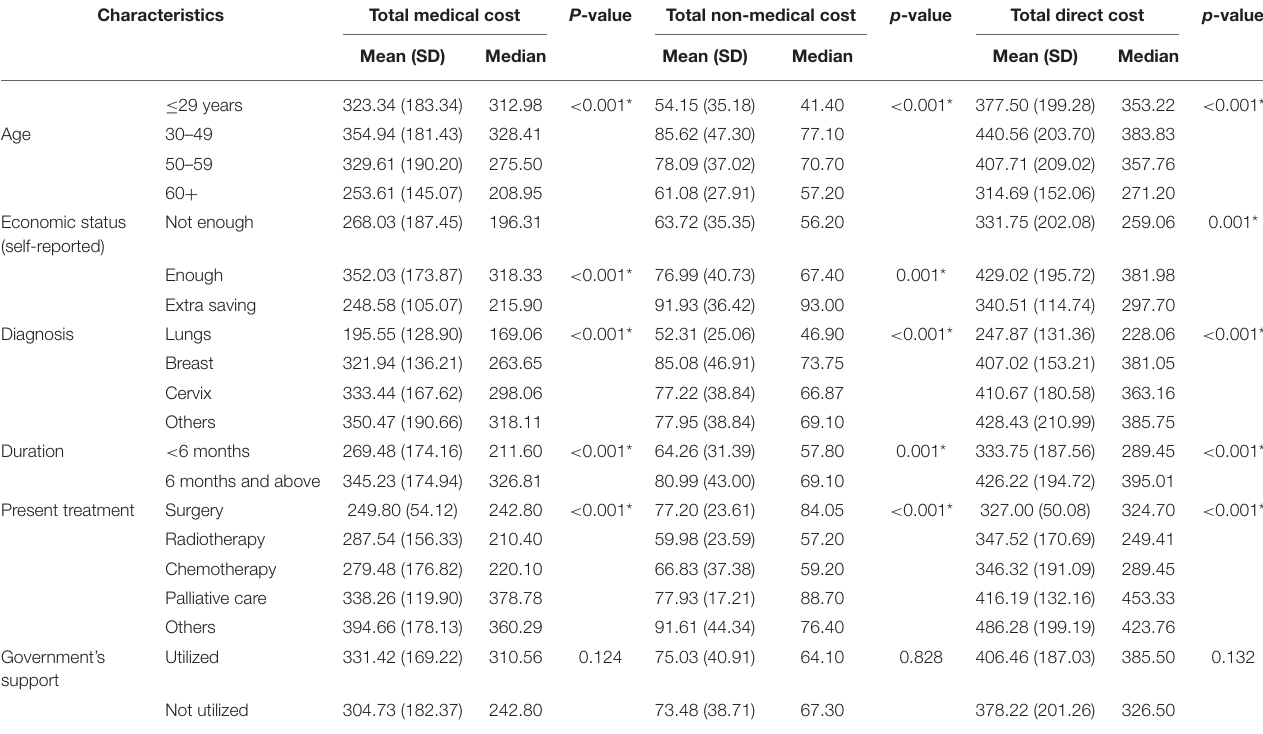
TABLE 4 | Bivariate analysis of direct cost (NRs ‘000) of cancer ( n = 294).